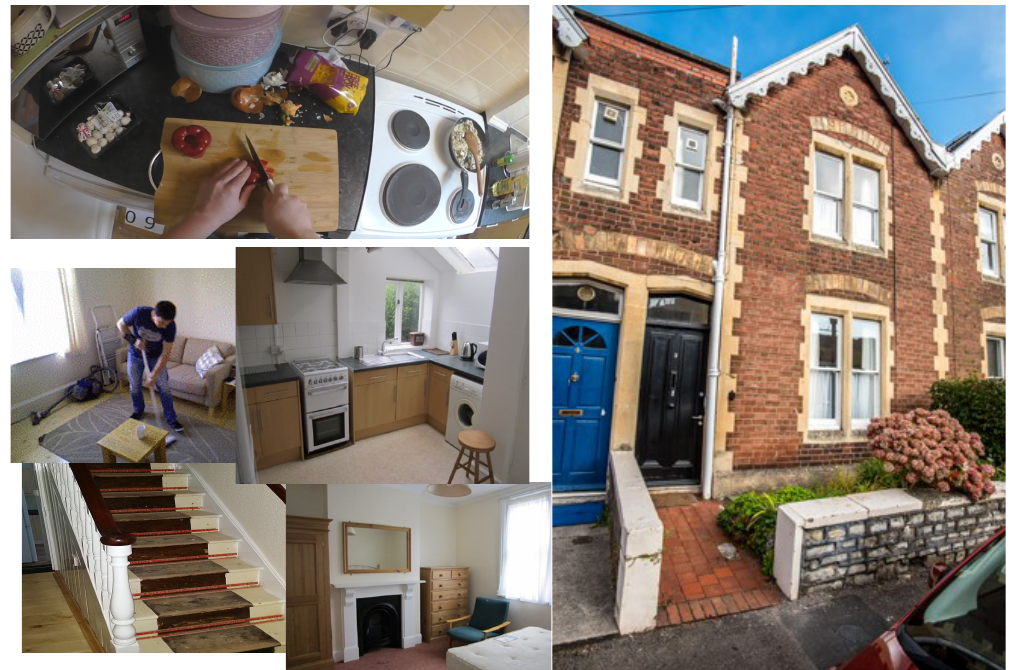
Figure 6. The SPHERE house at the University of Bristol and the kitchen